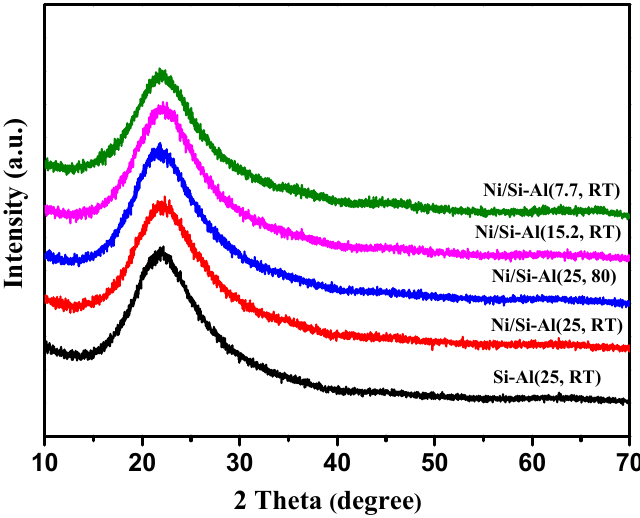
Figure 1. The XRD patterns of prepared catalysts at different conditions.